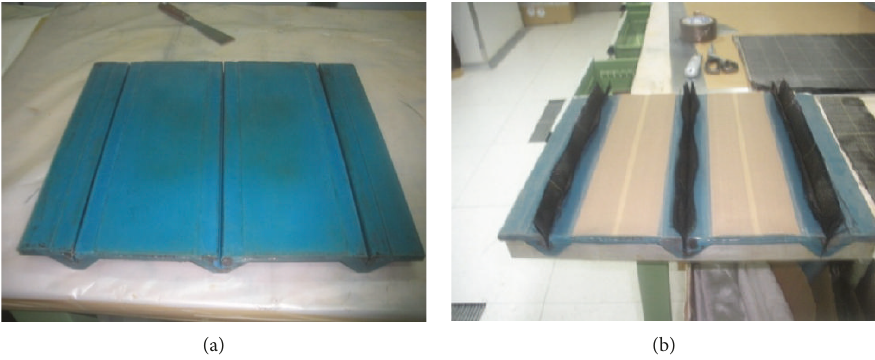
Figure 10: (a) Rubber tool and (b) T stringer preforming.